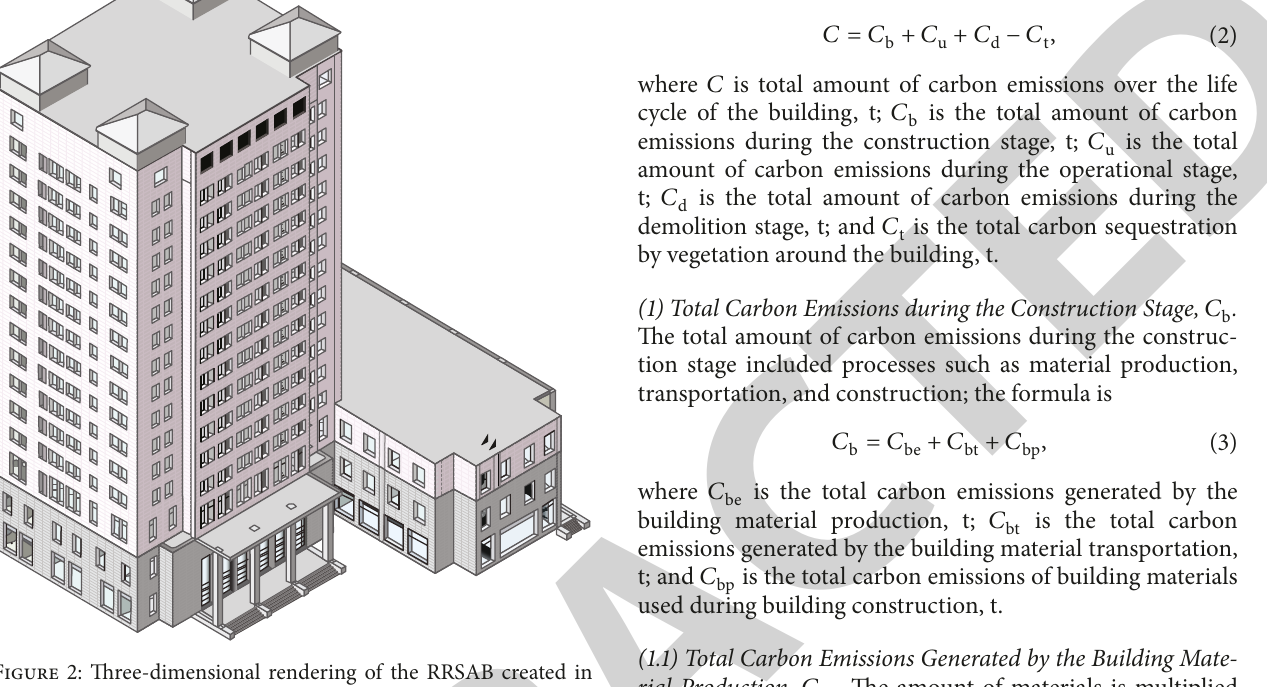
Figure 2: Three-dimensional rendering of the RRSAB created in Revit.